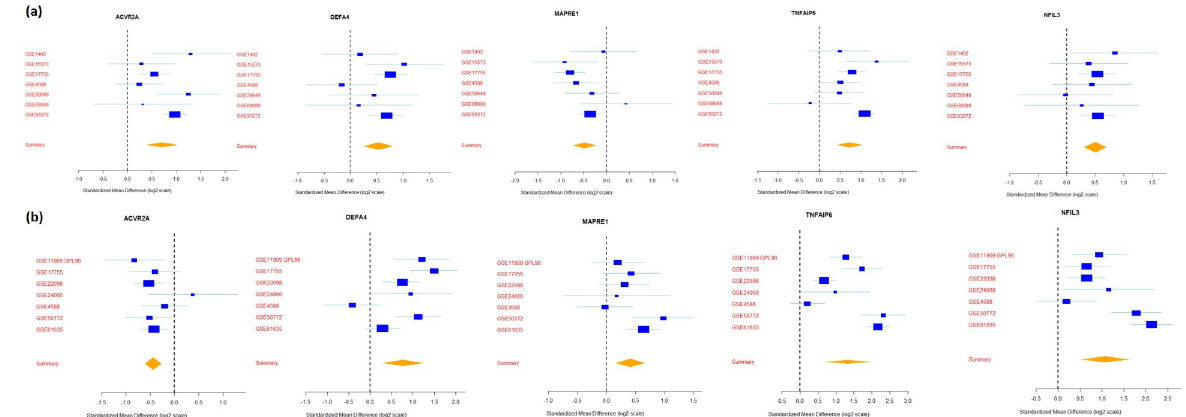
Fig 6. Forest plots of genes with persistent expression in all studies of RA (a) and SLE (b) . The x-axis shows the standardized mean difference (log2 scale) computed as Hedges’ g between disease and control samples for genes in multiple studies. The size of the blue box is inversely proportional to the standardized mean difference of the gene in each study. Whiskers represent 95% confidence intervals. The yellow diamond represents the combined mean difference for each gene and its width denotes the 95% confidence interval.